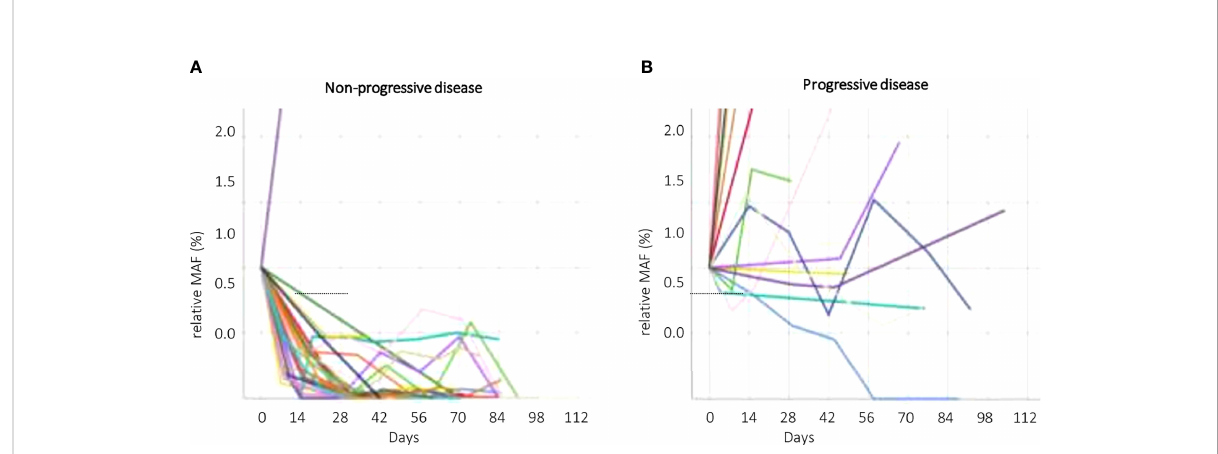
FIGURE 3 CtDNA kinetics according to response groups. Non – progressive disease (non – PD, A ) and progressive disease (PD, B ). Different patients (ctDNA kinetics) are symbolized by different colors. ctDNA, circulating tumor DNA; non – PD, non – progressive disease (complete response, partial response, stable disease); MAF, mutant allele frequency; PD, progressive disease.